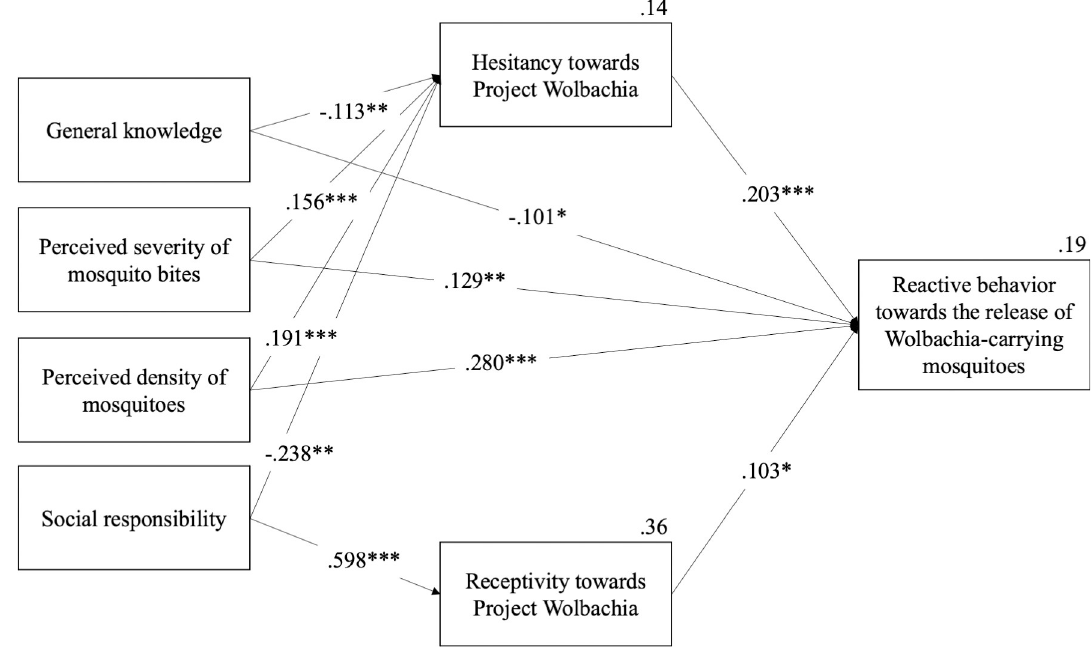
Fig 2. Public Wolbachia Response Framework: Predictors of reactive behavior towards release of Wolbachia -carrying mosquitoes. Significant pathways are shown with their standardized regression coefficients for direct effects. � p < .05, �� p < .01, ��� p < .00.